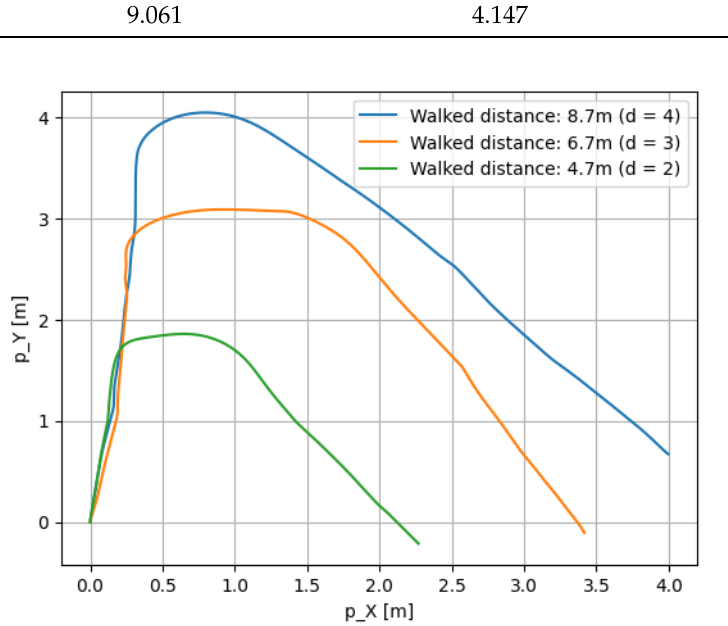
Figure 15. The results of route 2.